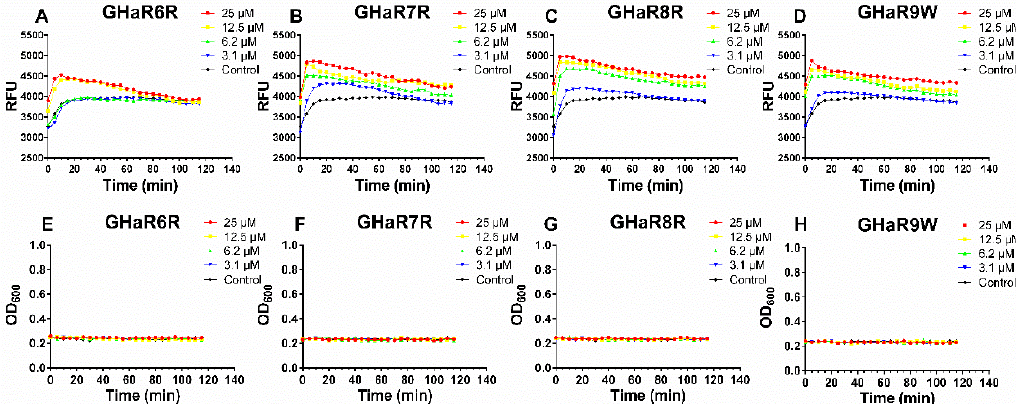
Figure 5. Membrane permeation after treatment with ( A ) GHaR6R, ( B ) GHaR7R, ( C ) GHaR8R, and ( D ) GHaR9W against S. mutans at 3.1–25 µ M in the presence of propidium iodide. Relative fluorescence units ( y -axis) were abbreviated as RFU in the figures. The growth inhibition curves of ( E ) GHaR6R, ( F ) GHaR7R, ( G ) GHaR8R, and ( H ) GHaR9W against S. mutans at 3.1–25 µ M within 2 h. The bacteria untreated with the peptides served as the negative control.